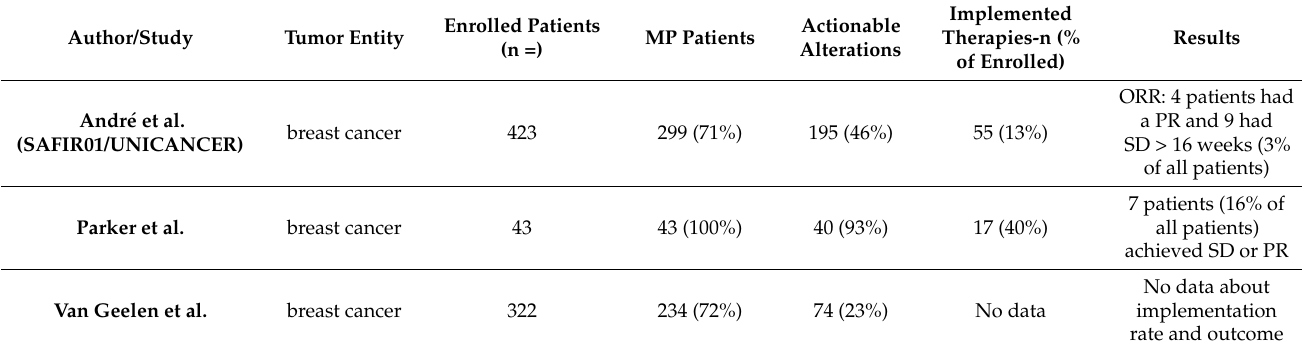
Table 1. Overview of studies focusing on molecular profiling in breast